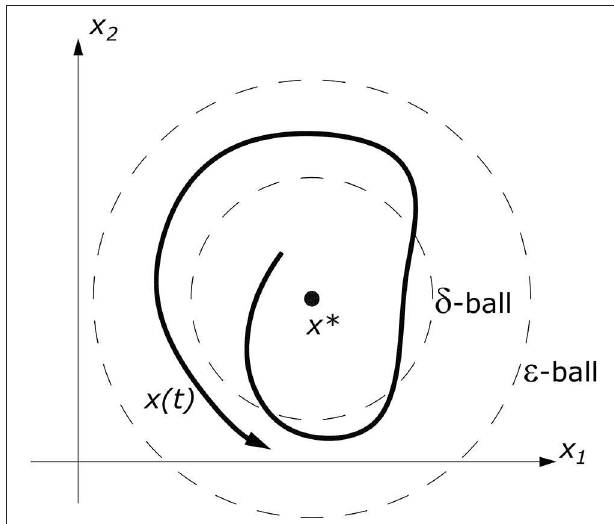
FIGURE 2 | Geometric interpretation of stability in the sense of